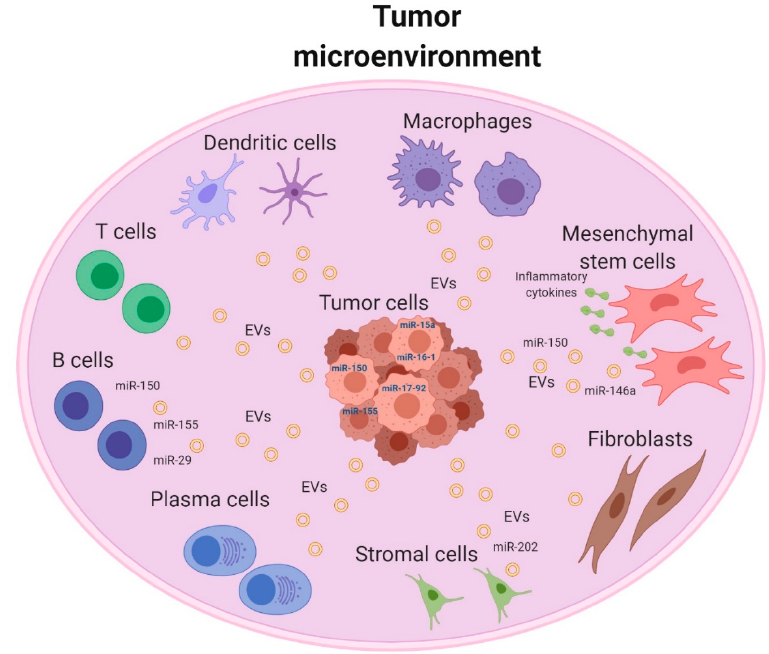
Figure 2. Schematic overview of tumor microenvironment of B- cell malignancies. Tumor cell-derived exosomes contain specific microRNAs (miRNAs) that can participate in the generation of a tumor microenvironment through paracrine signaling. (Figure is created with BioRender.com).